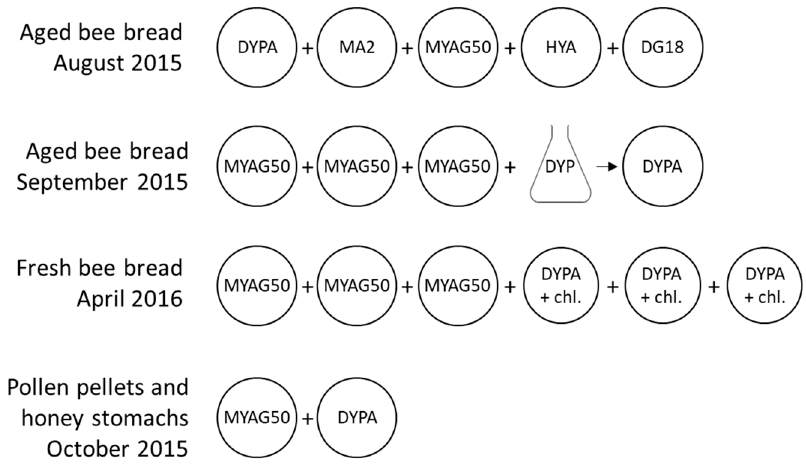
Figure 2. Overview of cultures on Dextrose Yeast Extract Peptone Agar (DYPA), Malt Agar 2% (MA2), Malt Yeast Agar Glucose 50% (MYAG50), Honey Yeast Agar (HYA), Dichloran-Glycerol Agar (DG18), and DYPA with chloramphenicol 200 mgL − 1 (DYPA + chl). Single plating was performed to determine the most appropriate media on 27 bee bread samples and on pollen pellets and honey stomachs because of the small sample quantities. Triplicate plating was performed on 80 bee bread samples.